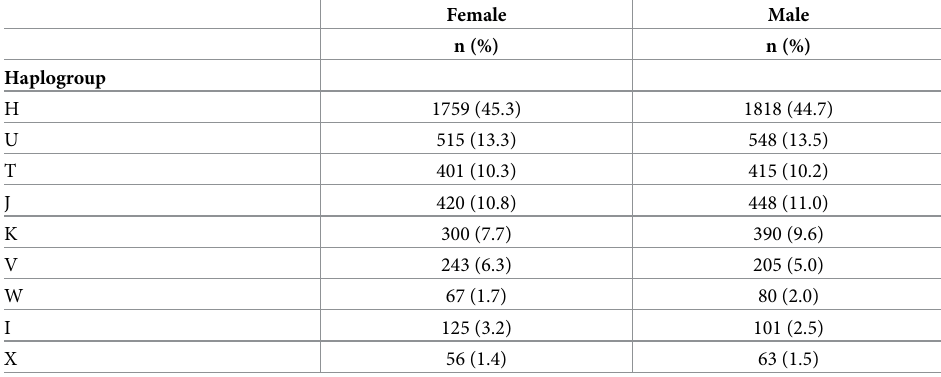
Table 1. Characteristics of ALSPAC participants included in analysis, by sex *